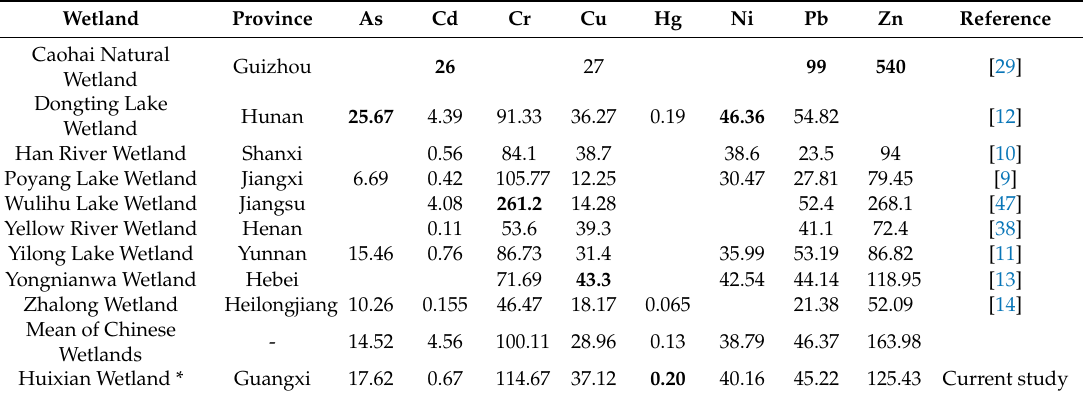
Table 2. Comparison between heavy metal concentrations (mg / kg) found in sediment in this and the previously published studies of Chinese wetlands (mean